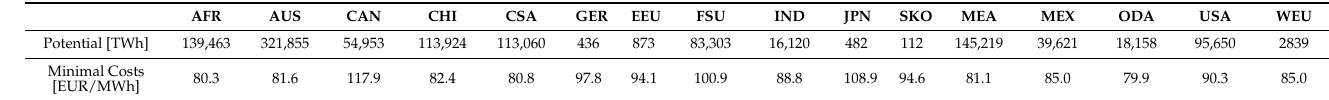
Table 3. Synfuels’ export potentials and costs per TIAM regions in 2050 [50].